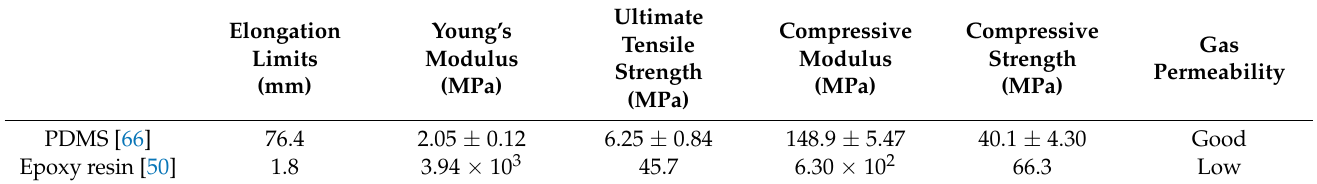
Table 2. Mechanical properties of PDMS and epoxy